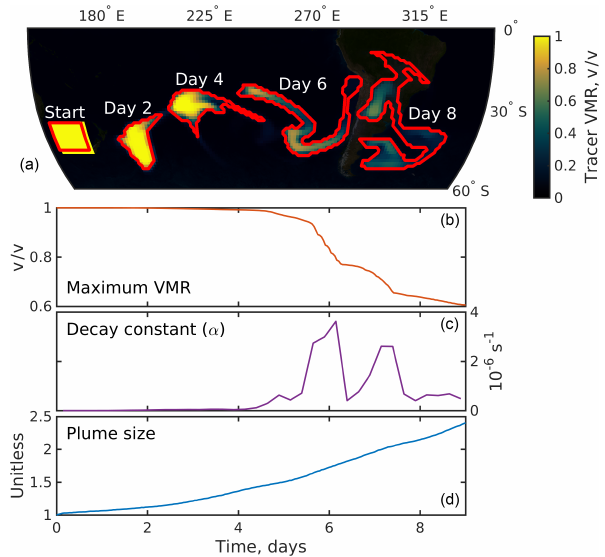
Figure 2. Numerical diffusion of a 2-D (horizontal), inert plume in GEOS-Chem for a 9-day simulation at 1 ◦ × 1.25 ◦ horizontal reso- lution. This particular plume was initialized between Australia and New Zealand (Fig. 1). The red contour shows the minimum area containing 90% of the tracer mass. From top to bottom, the lower three panels show the normalized maximum VMR in the plume; the 6h moving average decay constant α calculated from Eq. (5); and the plume size, defined as the square root of the 90% contour area and normalized by the initial